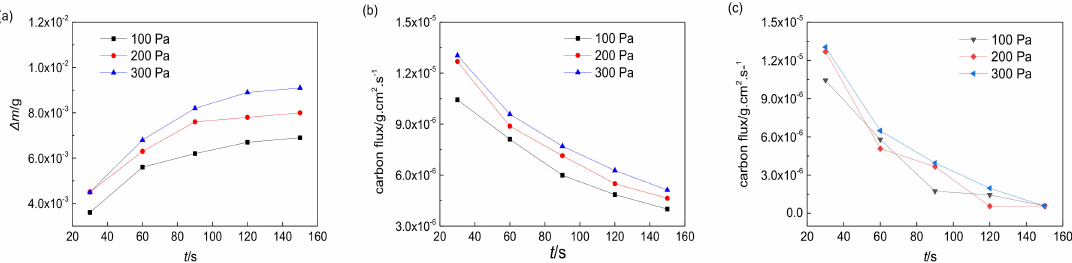
Figure 7. E ff ect of carburizing pressure on ( a ) mass increment, ( b ) average carbon flux, and ( c ) segmented average carbon flux for 12Cr2Ni4A steel at 950 ◦ C.